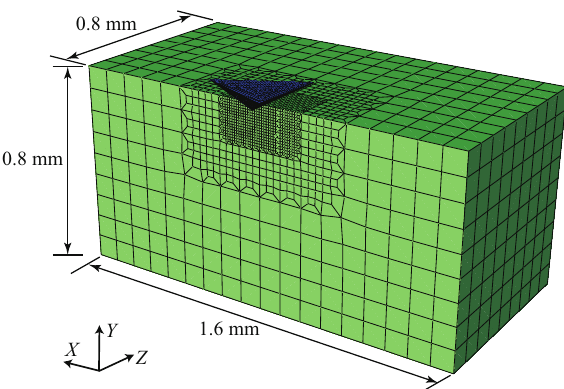
Figure 1. Finite element model of the instrumented indentation test.